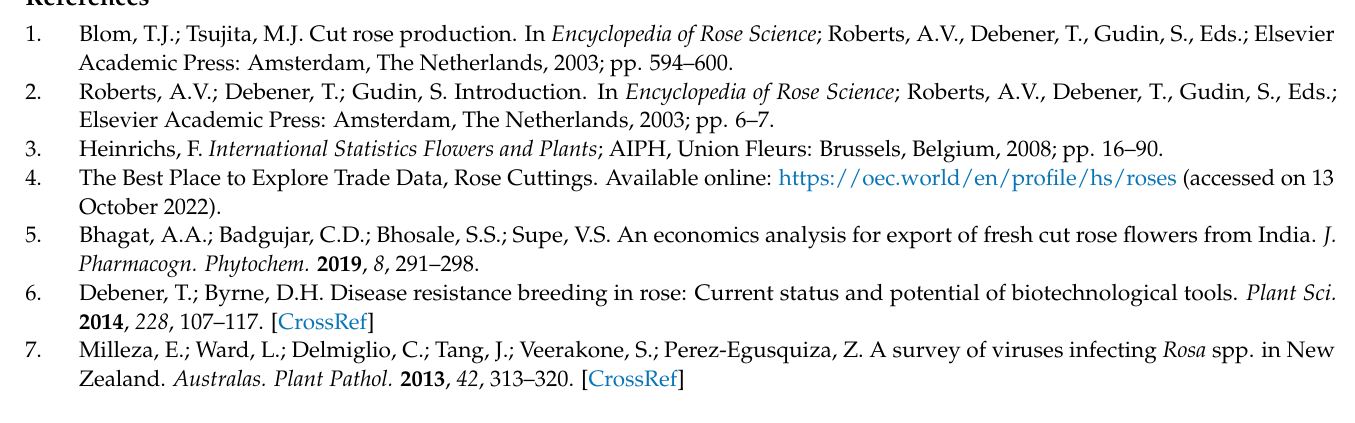
Table S2: Primers used for genome sequencing of rose ilarvirus 2, Table S3: GenBank accession codes for genome sequences of Ilarvirus species analyzed in this study, Table S4: Viruses were detected in the rose samples shown in Figure 1, Table S5: Annotation result